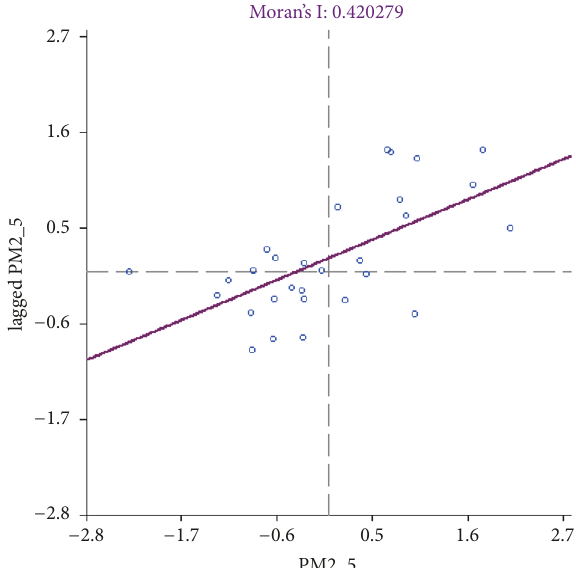
Figure 3: Moran’s I index scatter plot of PM 2.5 average in China.